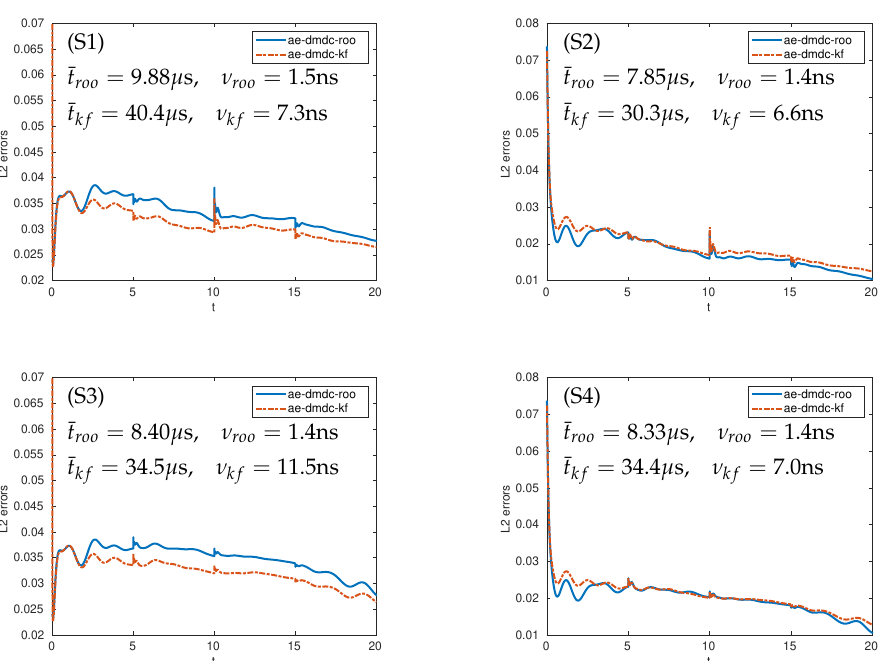
Figure 8. Comparison of the approximated L 2 observation error norm evolutions for the four different scenarios (S1) to (S4) with the respective mean computation times per unit step (¯ t roo , ¯ t kf and the associated variances ν roo , ν kf obtained in the simulation